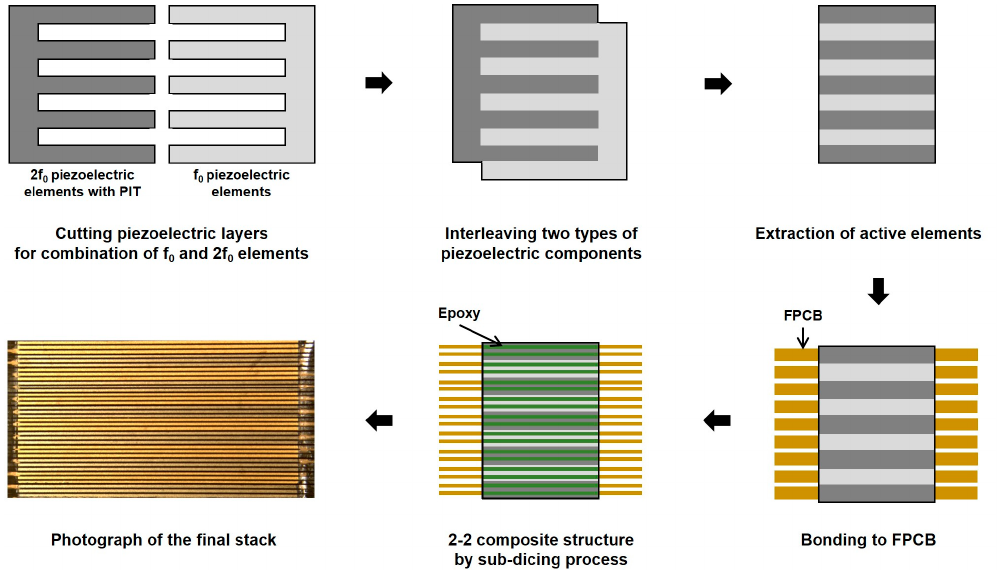
Figure 6. Fabrication process of the proposed prototype array transducer focusing on the novel interleaved technique.